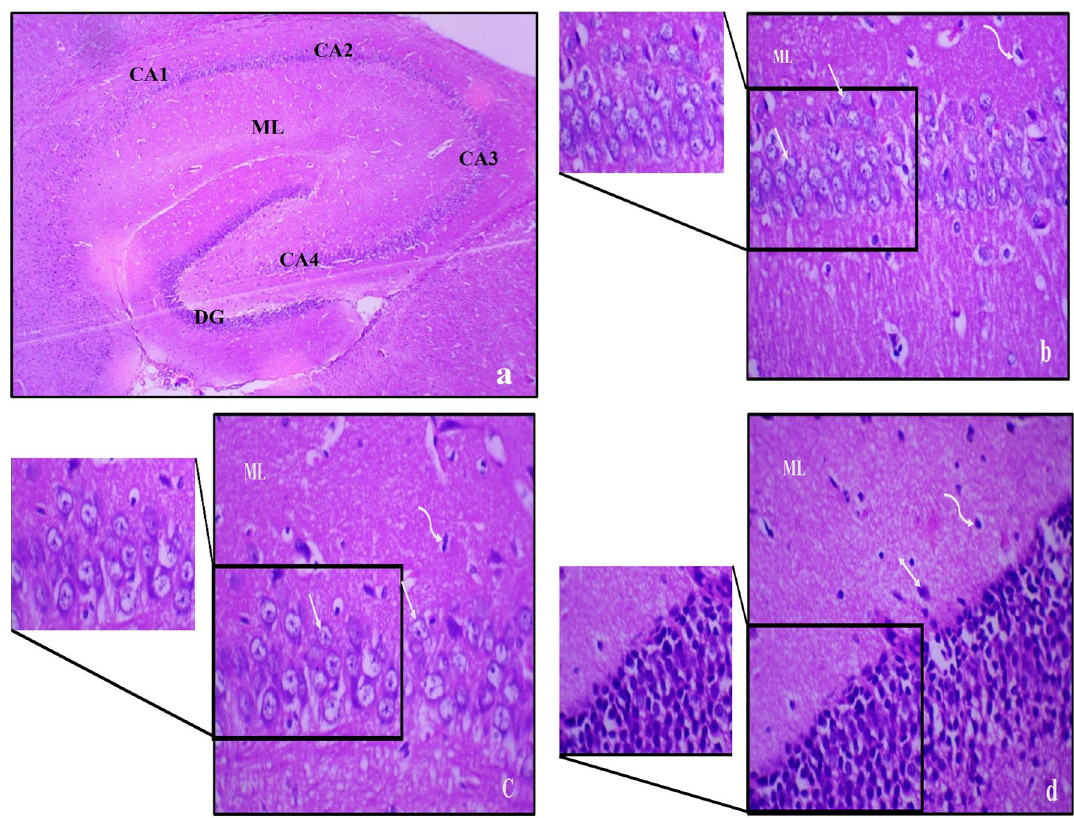
Figure 5. Photomicrograph of haematoxylin and eosin-stained sections from hippocampus of control male rat showing normal regions and histological structure of the hippocampus, where; ( a ) The hippocampus proper is formed of the Cornu Ammonis (CA) as CA1, CA2, CA3 & CA4 regions, and is continued as subiculum (S). Dentate gyrus (DG) is seen around CA4 by its upper & lower limbs. Molecular layer (ML) is in between CA and of DG (H & E ×40). ( b ) 4–5 compact layers of small pyramidal neurons of CA1 region, most with vesicular nuclei ( ↑ ); ( c ) shows few layers of large pyramidal neurons in CA3 region, also with vesicular nuclei ( ↑ ); ( d ) shows layers of compact granular cells with dark nuclei in dentate gyrus. Molecular layer (ML) shows many glial cells (wavy arrow) as well as pyramidal cells ( ↕ ) [H & E; ( a ) ×40, ( b – d )